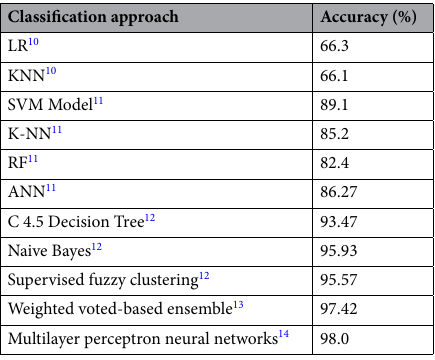
Table 1. Performances of various classification models used for BC